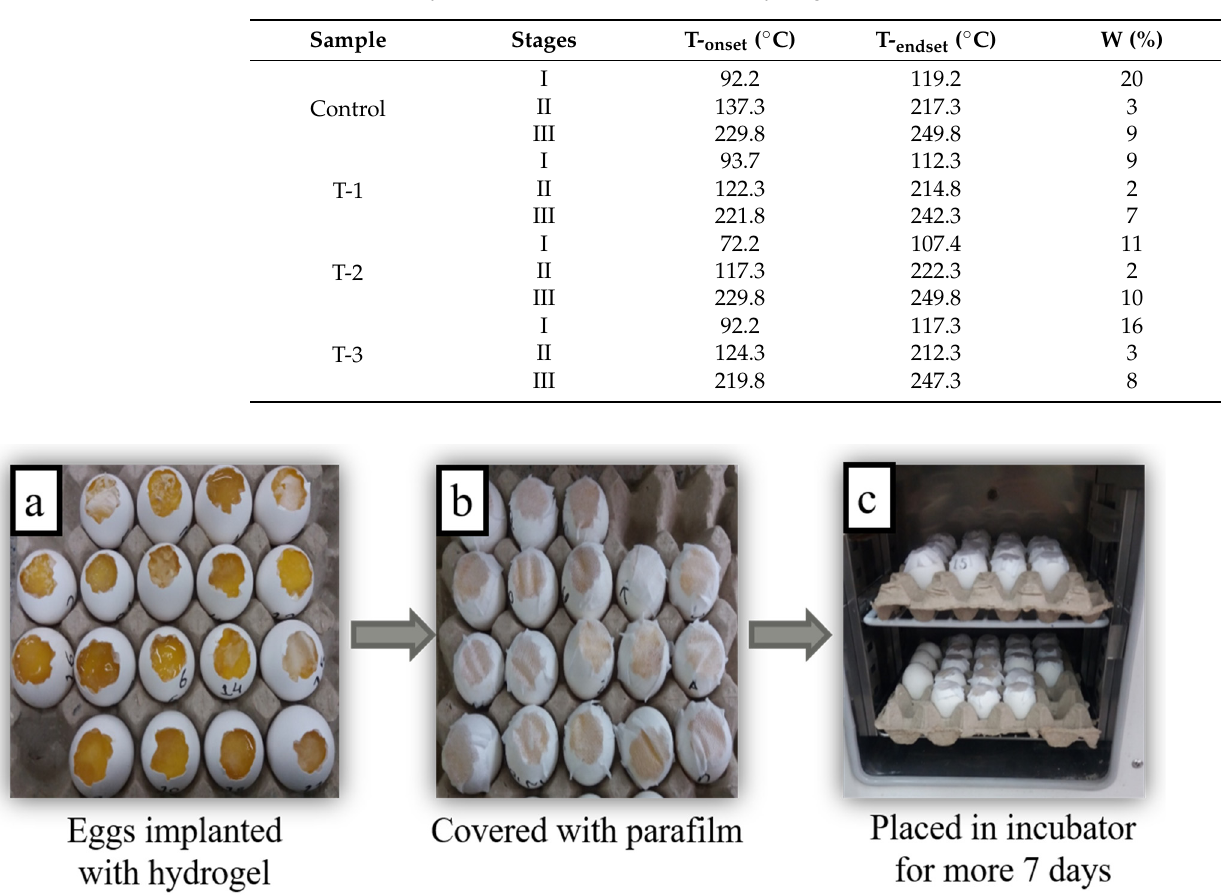
Table 1. TGA analysis of Control, T-1, T-2, and T-3 hydrogels.